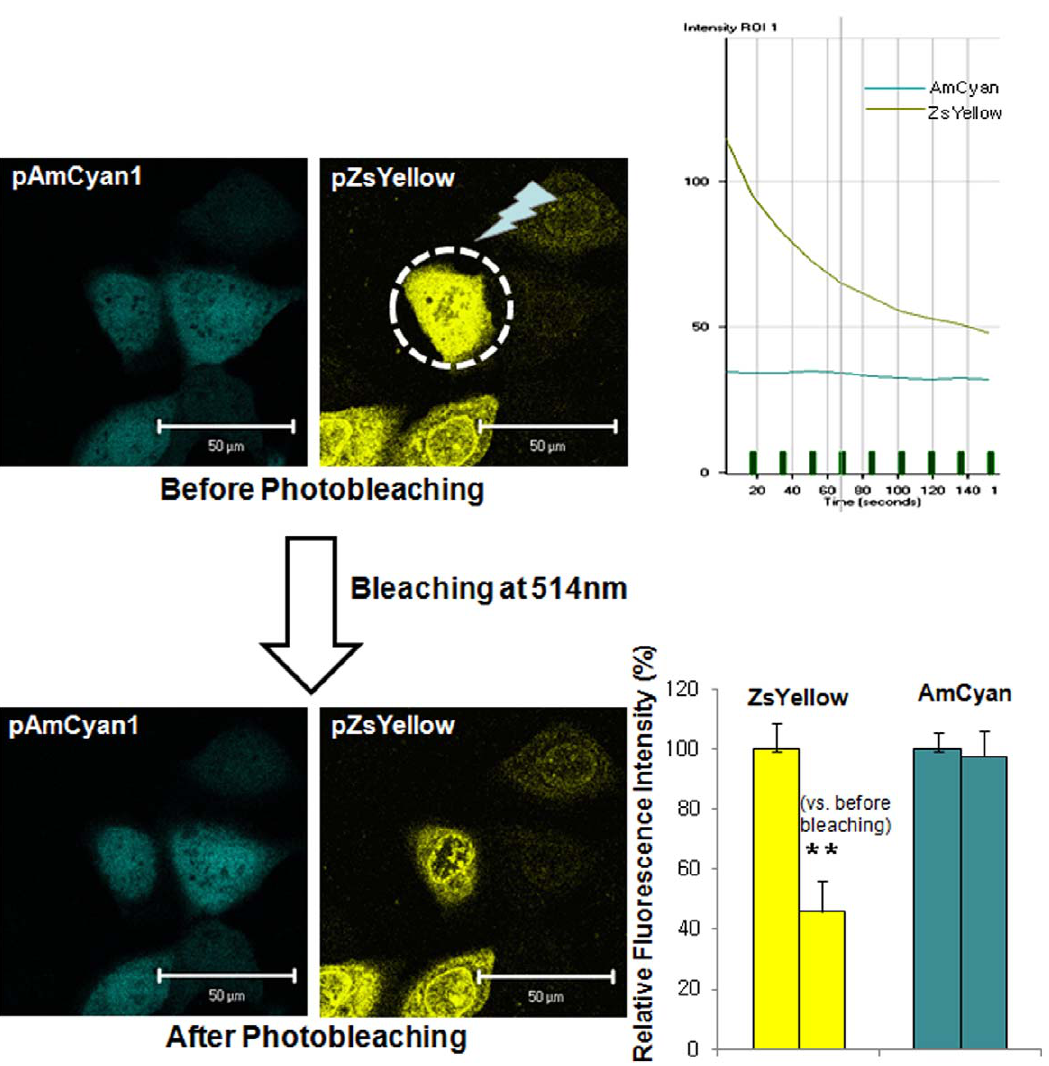
Figure 8. Molecular interaction between pZsYellow vector and pAMCyan1 vector was examined by FRET. HEK 293 cells on coverlips in 6-well plates were transiently co-transfected with pZsYellow vector and pAMCyan1 vector. Figures in the left panel show representative results from the seven independent experiments. The right upper panel shows a representative graph indicating the time-lapse fluorescence changes in the region of interest (ROI). Green line: AMCyan1 fluorescence; gray: ZsYellow throughout the progression of successive bleaching marked as vertical green bars. In the right lower panel, relative fluorescence intensity is denoted after standardization of intensities before and after photobleaching of ZsYellow at 514 nm. * p , 0.05 versus fluorescence intensity before photobleaching of ZsYellow at 514 nm (by Student’s t-test). Scale bars=50 m m.